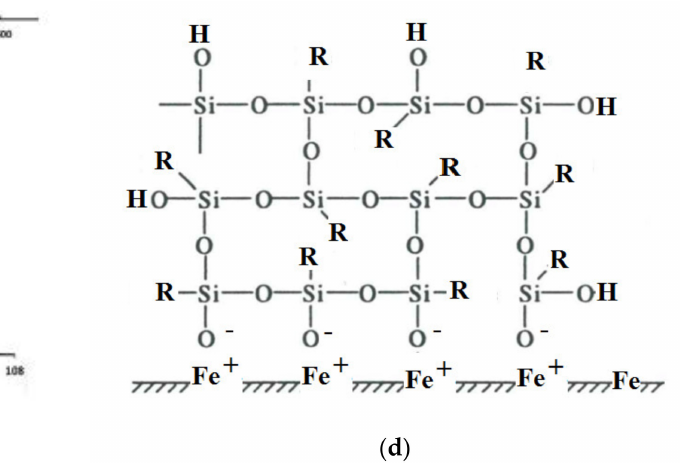
Figure 6. Auger ( a , b ) and XPS spectra ( c ) of thin films after BTMS vapour deposition on the iron surface. ( a )—5 monolayers, ( b , c )—12 monolayers. ( d )—schematic drawing of the oxidised iron surface with adsorbed siloxane [21]. Published with permission from NAUKA/INTERPERIODIKA